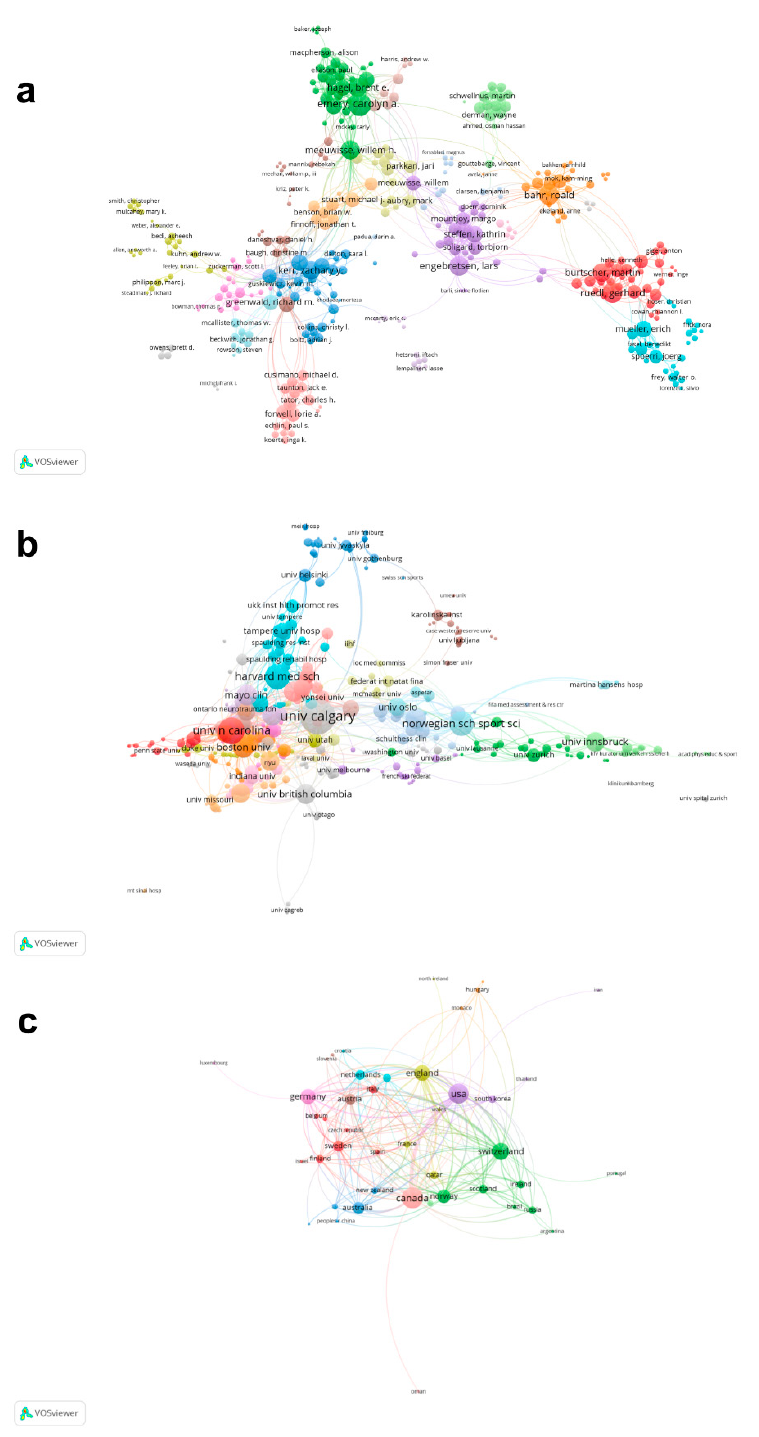
Figure 3. Co-authorship analysis of global research about ice and snow sports injuries. ( a ) Network visualization mapping for the 837 identified authors. ( b ) Network visualization mapping for the 525 identified affiliations. ( c ) Network visualization mapping for the 46 identified countries/regions. The size of the nodes indicates the frequency of co-authorship. Lines between two nodes indicate that those two authors/affiliations/countries/regions have established collaboration ties. The color of an element indicates the cluster it belongs to, and different clusters are indicated by different colors.